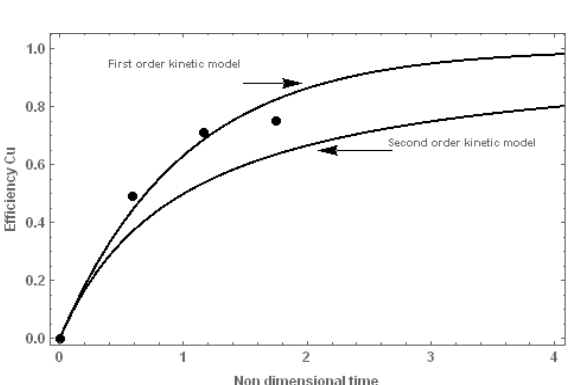
Figure 5. EC experimental results of removal efficiency (points) as well as the first and